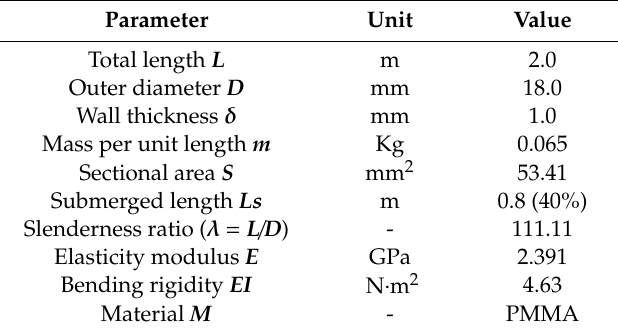
Table 1. Detailed parameters of the